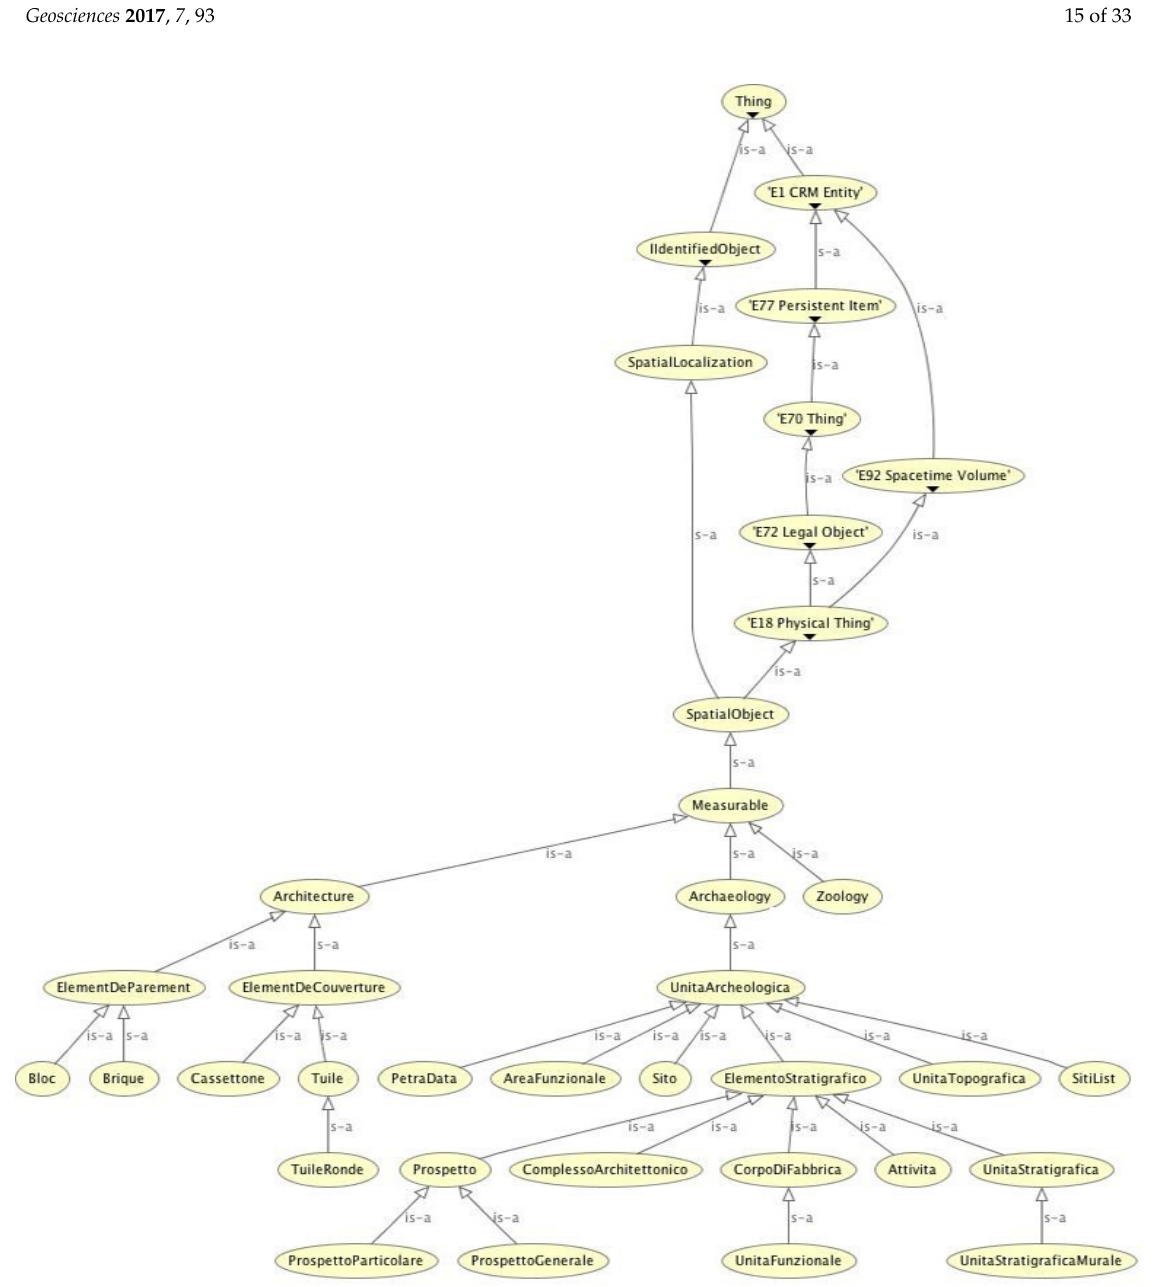
Figure 10. Partial ontology visualization with CIDOC CRM